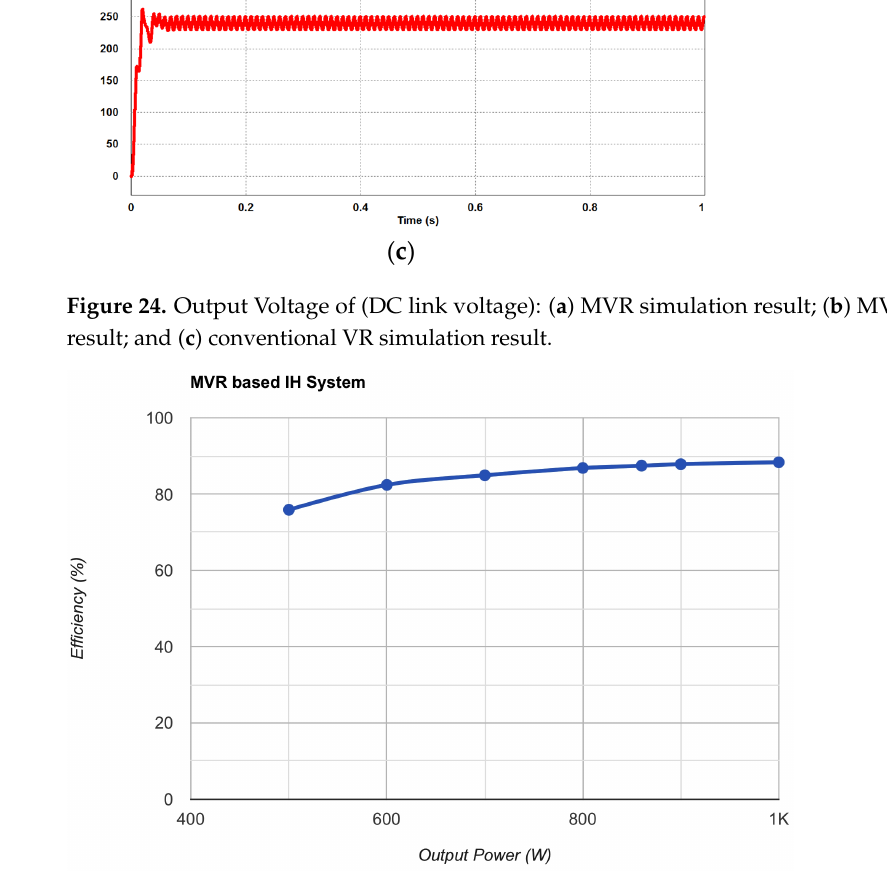
Figure 25. Experimentally obtained efficiency versus output power.